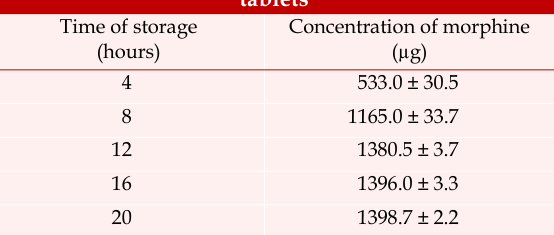
Dissolve test of sustained release morphine sulfate